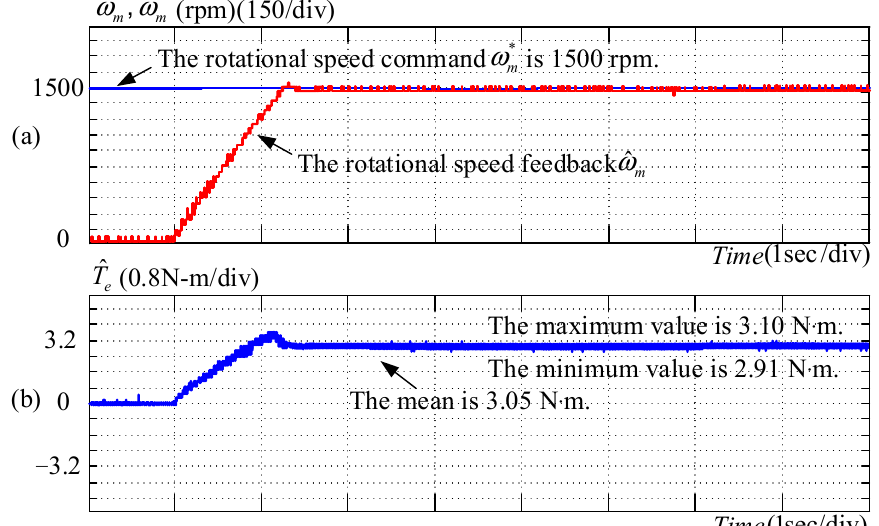
Figure 12. Measured rotational speed and electromagnetic torque of a three-phase permanent-magnet synchronous motor driven at 1500 rpm with a compensation strategy for harmonic components in induced EMF along the a-axis, b-axis, and c-axis: ( a ) measured rotational speed ω ∗ m and rotational speed feedback ˆ ω m ; ( b ) measured electromagnetic torque ˆ T e .